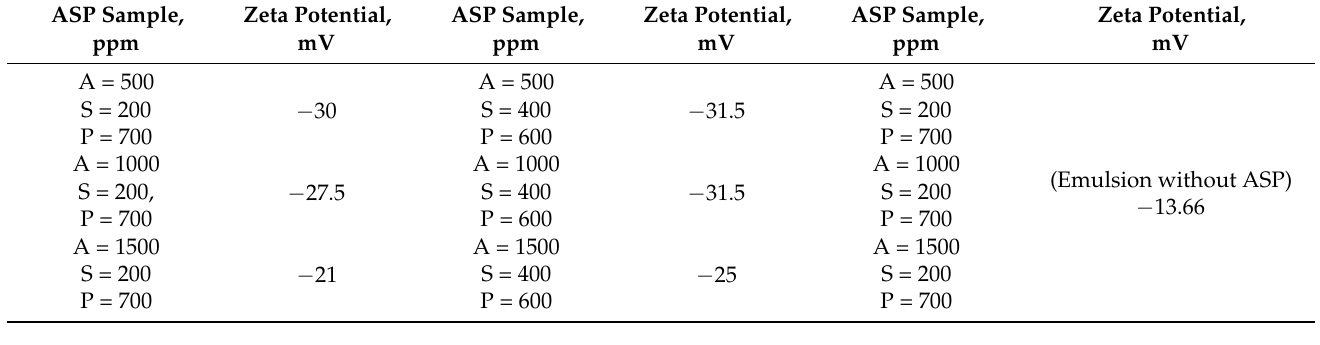
Table 11. Zeta potential of dispersed droplets with and without ASP injection.